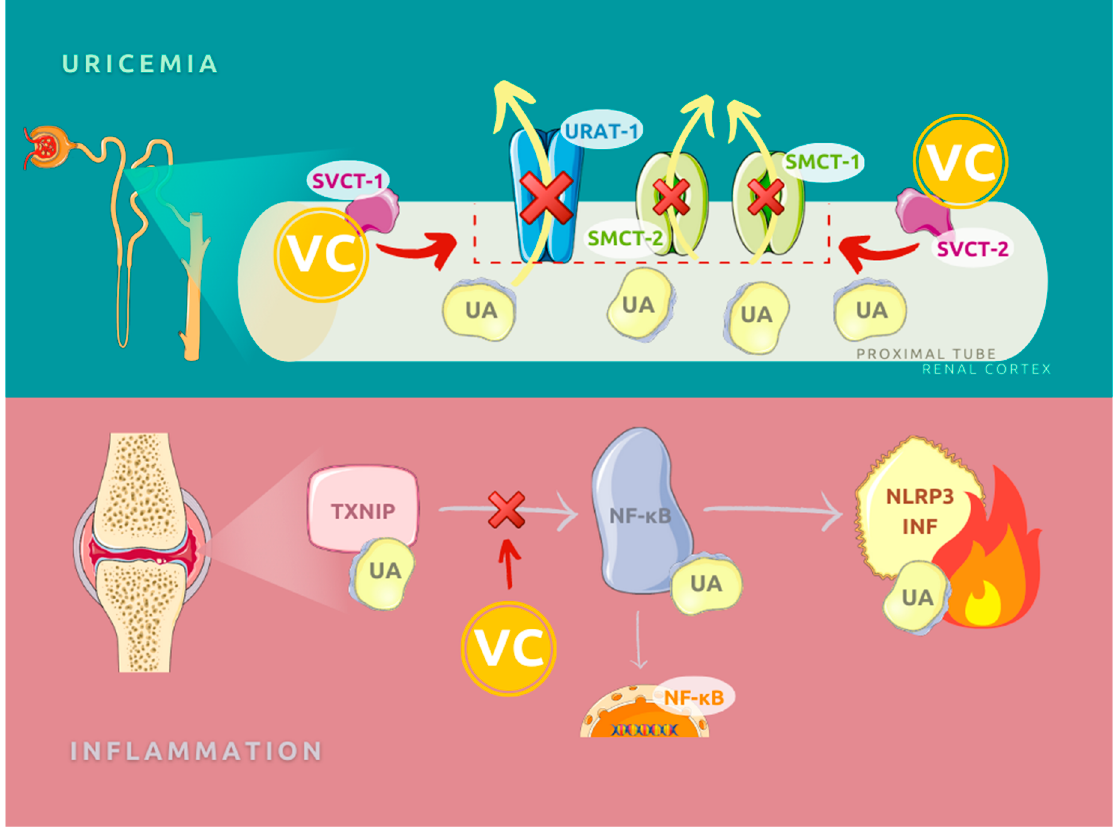
Figure 2. Molecular role of vitamin C in the transport of uric acid in the proximal renal tubules and in inflammatory process regulation. VC: vitamin C, UA: uric acid, URAT-1: urate transporter 1, SMCT: sodium-coupled monocarboxylate transporter, SVCT: sodium-dependent vitamin C transporter, TXNIP: thioredoxin-interacting protein, NF- κ B: nuclear factor kappa-light-chain-enhancer of activated B cells, NLRP3 INF: NLR family pyrin domain containing 3 inflammasome.